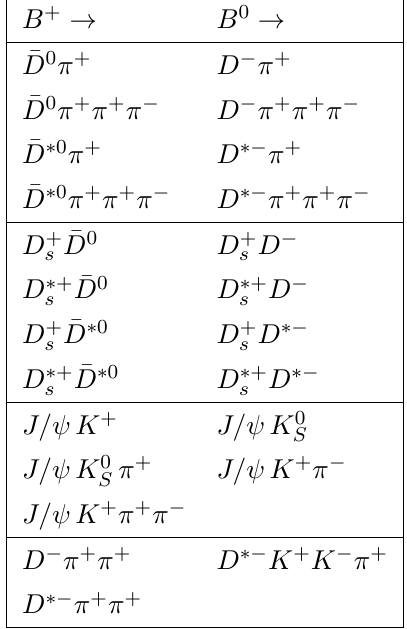
Table 9 . Decay channels of B + and B 0 used in FEI.